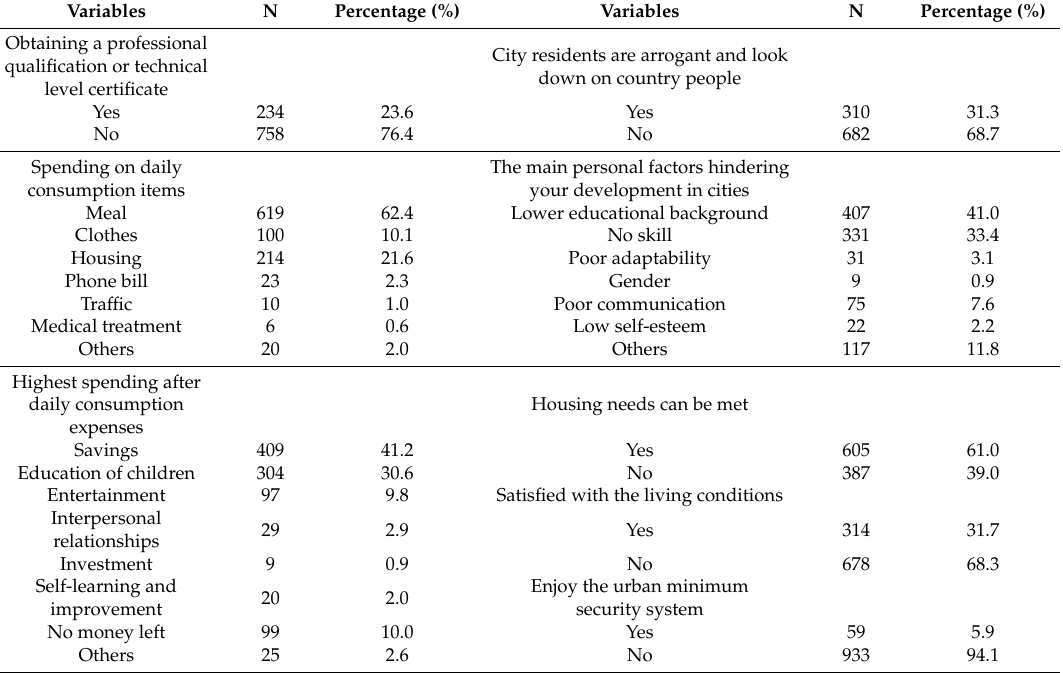
Table 2. Key variables of female migrant workers’ livelihood vulnerability in